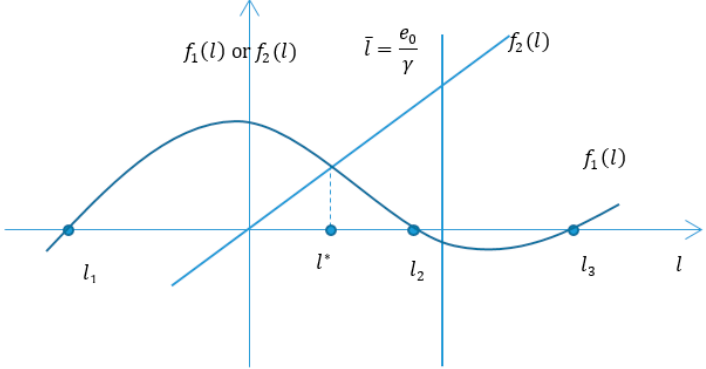
Figure A2. The curve of the function (cid:1858) (cid:2869) ((cid:1864)) or (cid:1858) (cid:2870) ((cid:1864)) in Sub-case B.1.